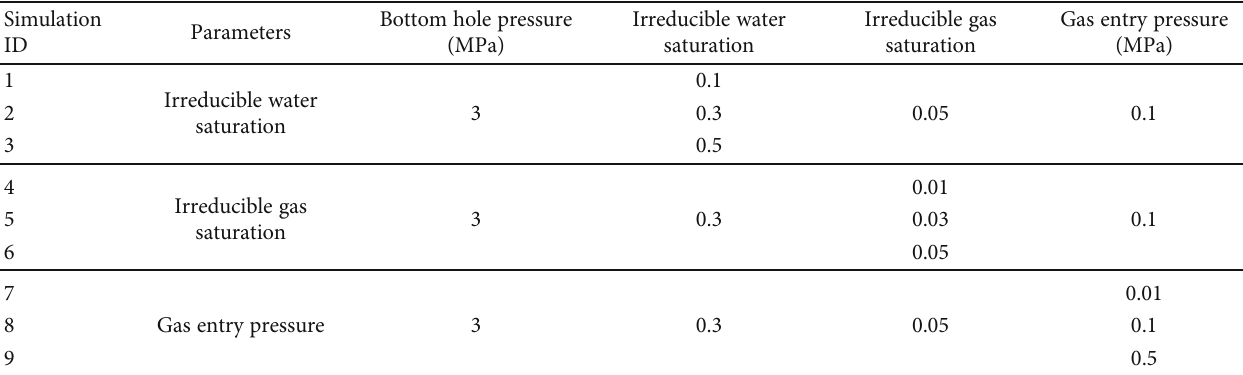
Table 2: Simulation parameters in di ff erent